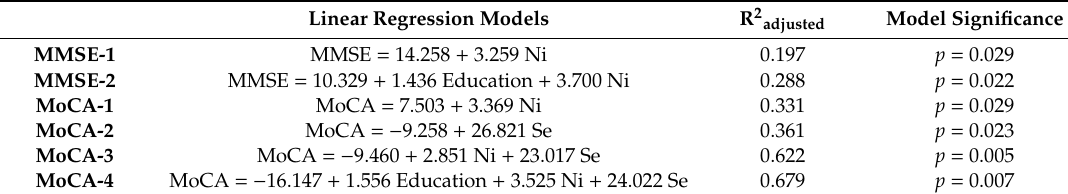
Table 3. Linear regression